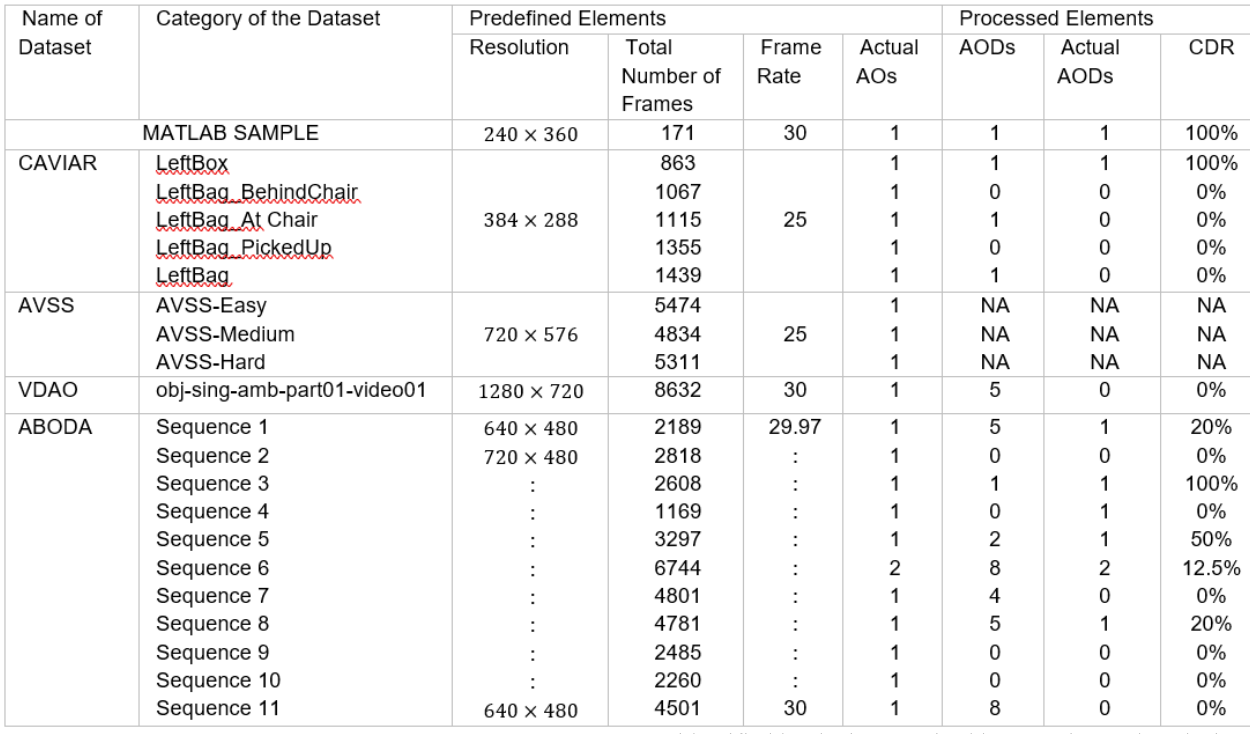
Table 4. CDR computation on the AOD dataset